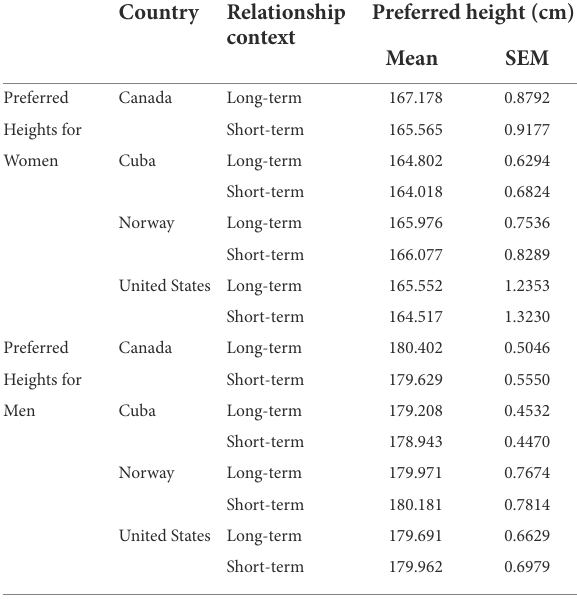
TABLE 2 Absolute (raw) height preferences by sex, country, and relationship context. These raw values do not account for variance due to individual or sample